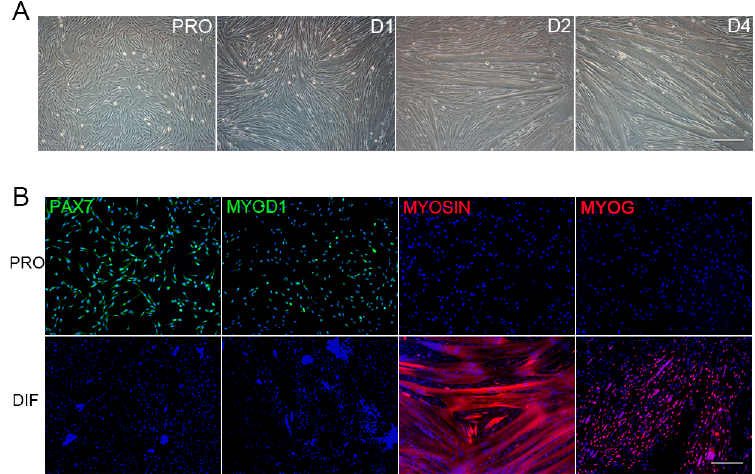
Figure 1. Porcine Satellite Cells (PSCs) culture, differentiation, and immunofluorescence detection. ( A ) The proliferation PSCs (PRO) were differentiated for 4 days in differentiation medium (D1, D2, and D4), and myotubes aroused at D2, with their size increasing over time. Scale bars: 200 μ m. Magnification: 100×. ( B ) Immunofluorescence detection of four marker genes in proliferation cells (PRO, upper panel), and D2 differentiated cells (DIF, bottom panel). Antibodies were indicated as green (left to right: PAX7, MYOD1) and red (left to right: MYOSIN, MYOG), Hoechst33342 dye was blue. Scale bars: 200 μ m. Magnification: 100×.